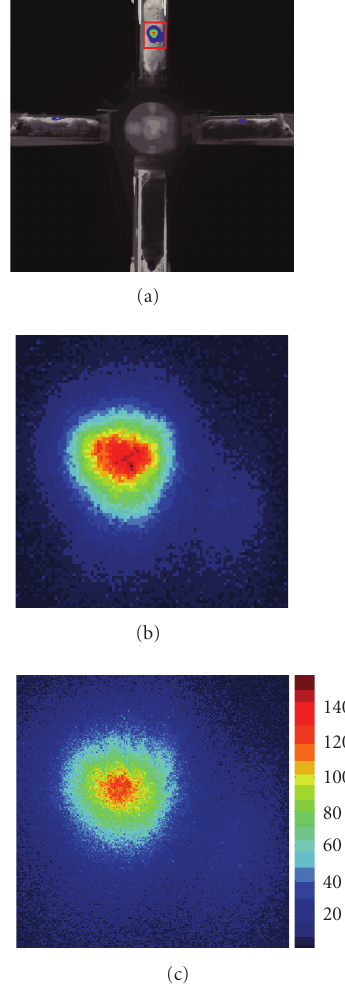
Figure 6: Bioluminescence images captured by our multiview sys- tem and the sequential system. (a) The four-view image of a mouse captured by the system in the spectral band [500,750]nm for 5- minute exposure time, (b) the corresponding image delimited by the red box in (a), and (c) the corresponding image captured using our original BLT system (sequential